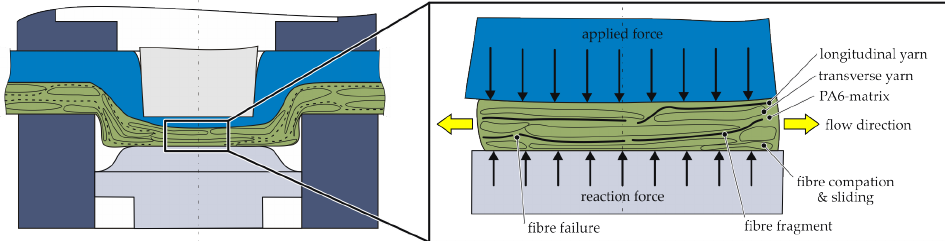
Figure 4. Schematic illustration of the occurring phenomena during upsetting phase as basis for the test rig development.